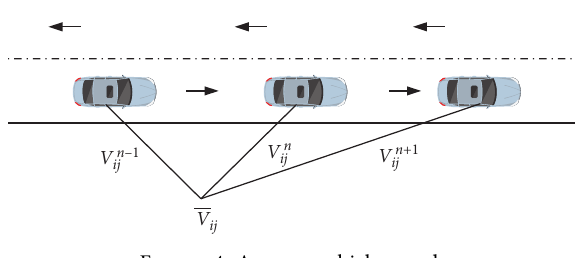
Figure 4: Average vehicle